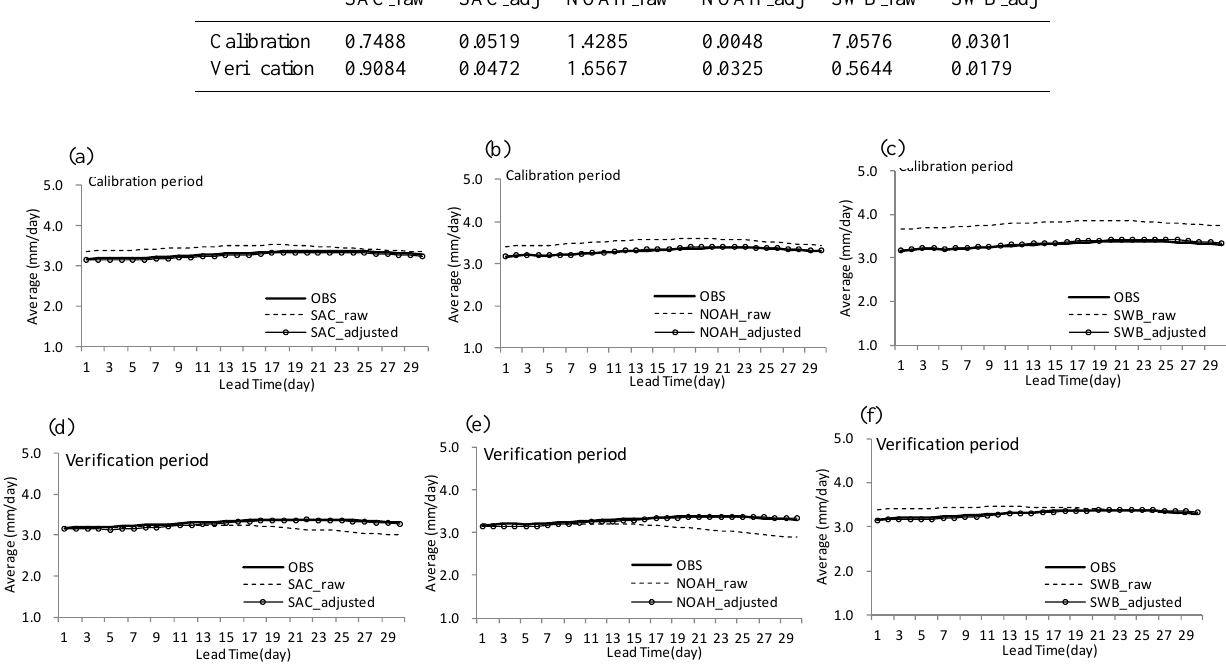
Fig. 3. The means of observed ensemble, raw ensemble, and GLMPP adjusted ensemble for the SAC, SWB and NOAH